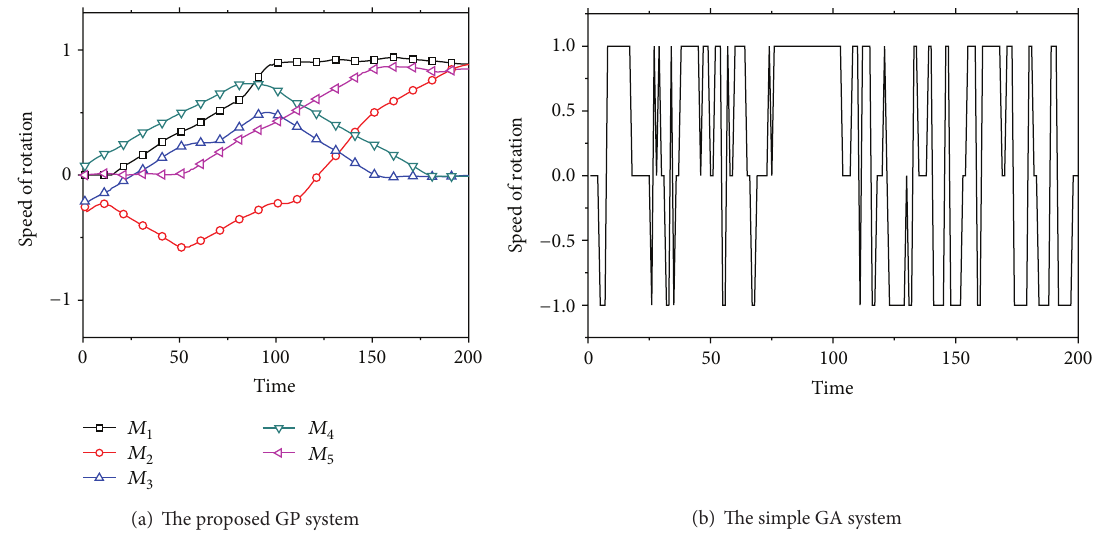
Figure 11: The generated signal patterns of the oscillators by the best individual at the 200th generation.